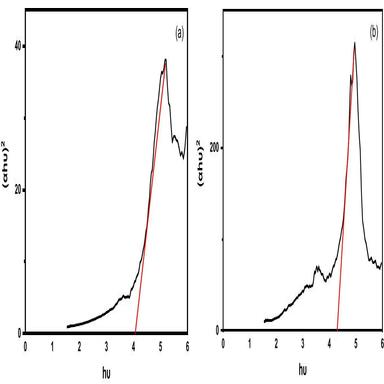
Band gap estimations from the absorption spectra (a) 2 sccm nitrogen doped graphene (b) 5 sccm nitrogen doped graphene on glass substrate.